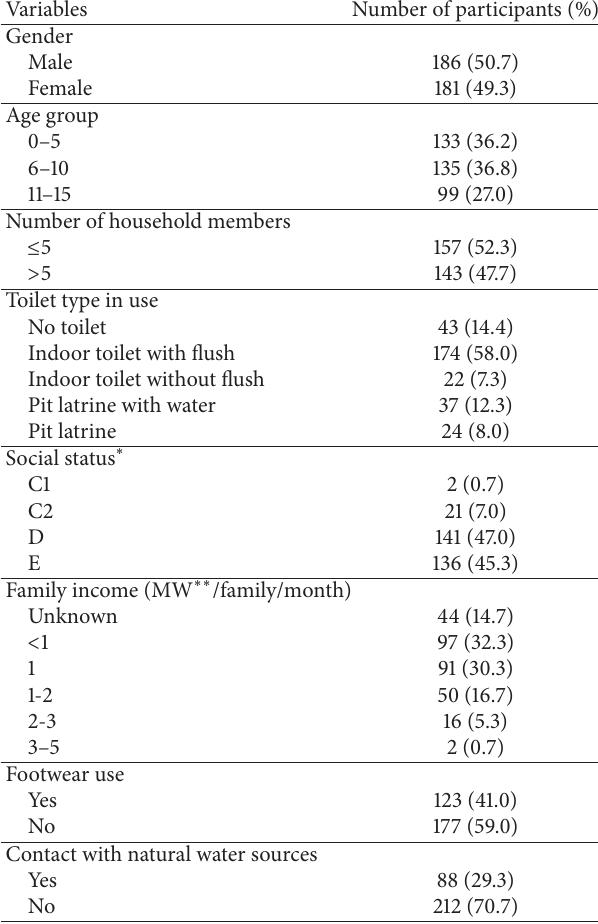
Table 1: Demographics and behavioral characteristics of children aged 0 to 15 years, living in a substandard settlement in Macei´o, Alagoas,